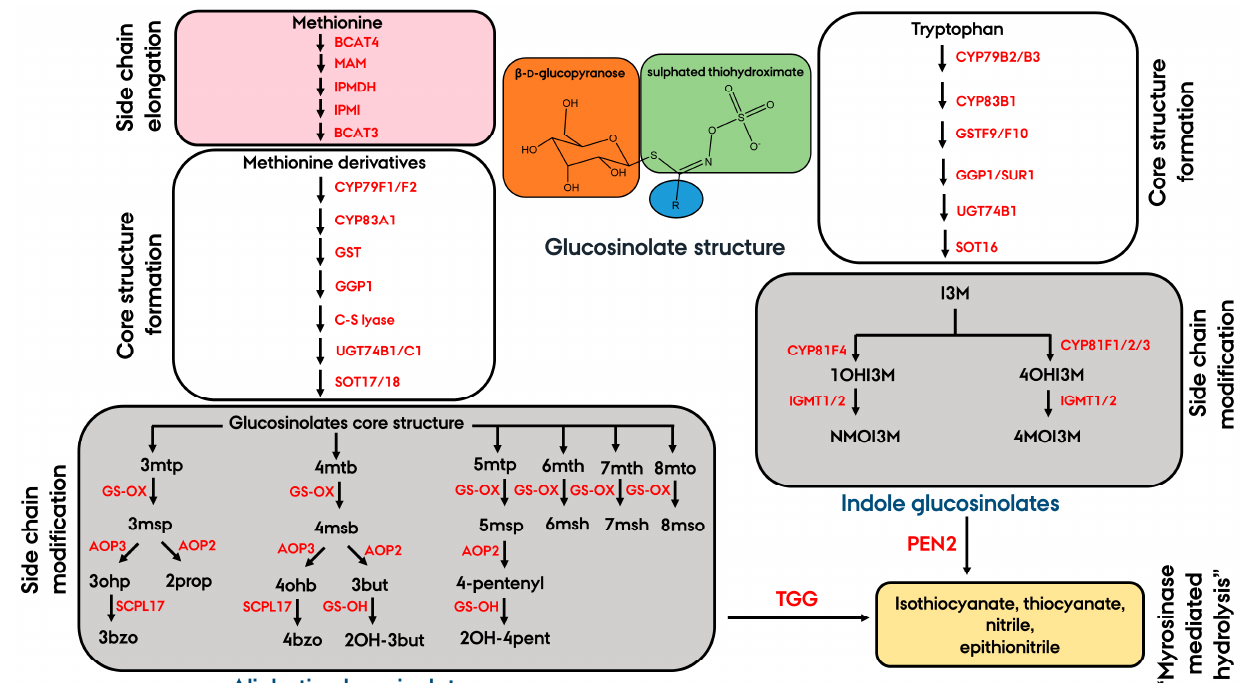
Figure 1. Schematic representation of the biosynthetic pathway leading to aliphatic glucosinolates, indole glucosinolates and their respective hydrolysis products in Arabidopsis thaliana root. Arrows between compounds represent the major enzymes (in red font) involved in the biosynthesis of glucosinolates. Glucosinolates are characterized by having a common core structure containing a β - D -glucopyranose residue (orange background) linked to a sulfated thiohydroximate (green background) with a variable side chain R group (blue background). Side-chain elongation of the precursor amino acid methionine (one to six methylene groups are sequentially inserted into the methionine side chain) is shown on a dark pink background. Glucosinolate side-chain modification is shown on a grey background. Glucosinolates are released from the vacuole and brought into contact with endogenous thioglucosidases called myrosinases such as Penetration2 (PEN2) or β -thioglucoside glucohydrolases (TGG) that mediate the degradation of glucosinolates to a variety of products, including isothiocyanates, thiocyanates, nitriles, and epithionitriles (yellow background). Abbreviations for intact glucosinolates and full names: 3mtp, 3-methylthiopropyl glucosinolate; 3msp, glucoiberin; 3ohp, 3-hydroxypropyl glucosinolate; 2prop, sinigrin; 3bzo, glucomalcomiin; 4mtb, glucoerucin; 4msb, glucoraphanin; 4ohb, 4-hydroxybutyl glucosinolate; 4bzo, 4-benzoyloxybutyl; 3but, gluconapin; 2OH-3but, progoitrin; 5mtp, 5-methylthiopentyl glucosino- late; 5msp, 5-methylsulfinylpentyl glucosinolate; 4-pentenyl, 4-pentenyl glucosinolate; 2OH-4pent, 2-hydroxy-4-pentenyl (or gluconapoleiferin); 6mth, 6-methylthiohexyl (or glucolesquerellin); 6msh, 6-methylsulfinylhexyl (or